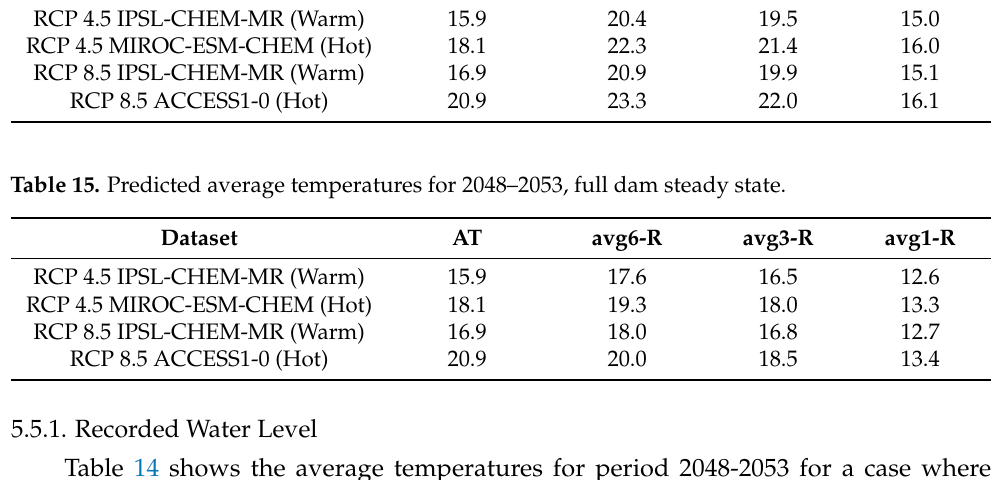
Table 14. Predicted average temperatures for 2048–2053, recorded water level. Dataset AT avg6-R avg3-R